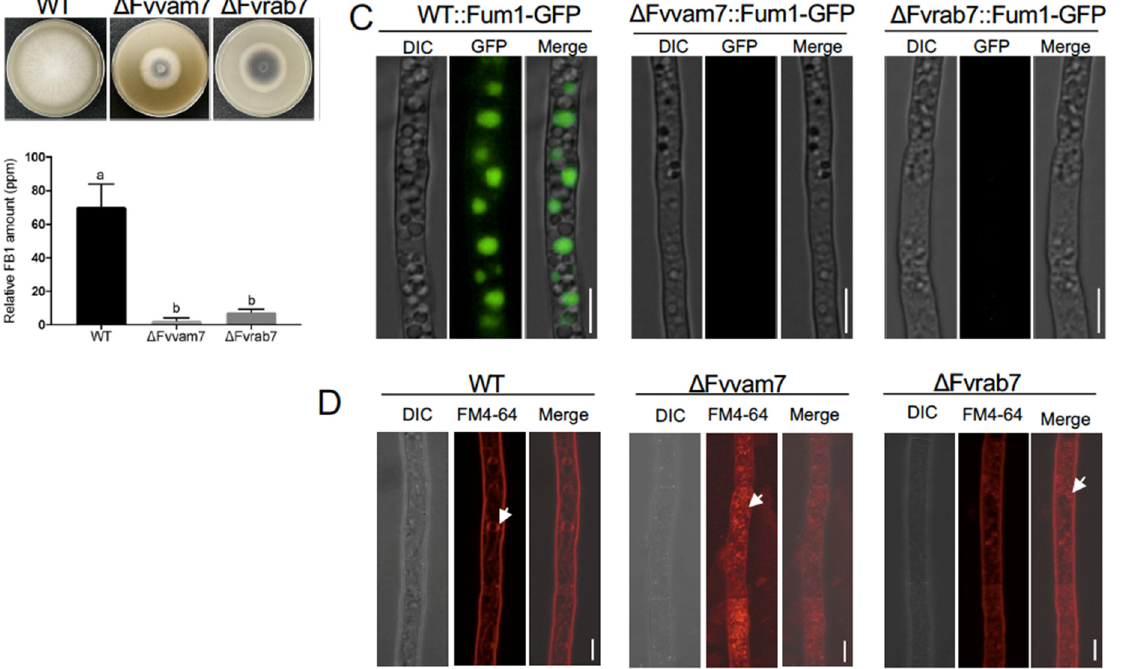
Figure 4. Colony growth and FB 1 production of Δ Fvvam7 and Δ Fvrab7 mutants. ( A ) Wild-type (WT), Δ Fvvam7, and Δ Fvrab7 strains were cultured on V8 agar plates for 7 days at 28 °C. ( B ) FB 1 levels in WT and mutant strains were normalized with fungal ergosterol levels. WT, Δ fvvam7, and Δ Fvrab7 strains were grown on autoclaved corn kernels for 8 days at room temperature before assay. Three replicates were performed for each strain. Different letters on the bars indicated significance according to prism Ordinary one-way ANOVA multiple comparisons at p < 0.05. ( C ) Fum1-GFP localization was determined in ∆ Fvvam7 and ∆ Fvrab7 compared to in WT strain. ( D ) FM4-64 was used to stain WT, ∆ Fvvam7, and ∆ Fvrab7 for vacuoles. Bar = 5 μ m.